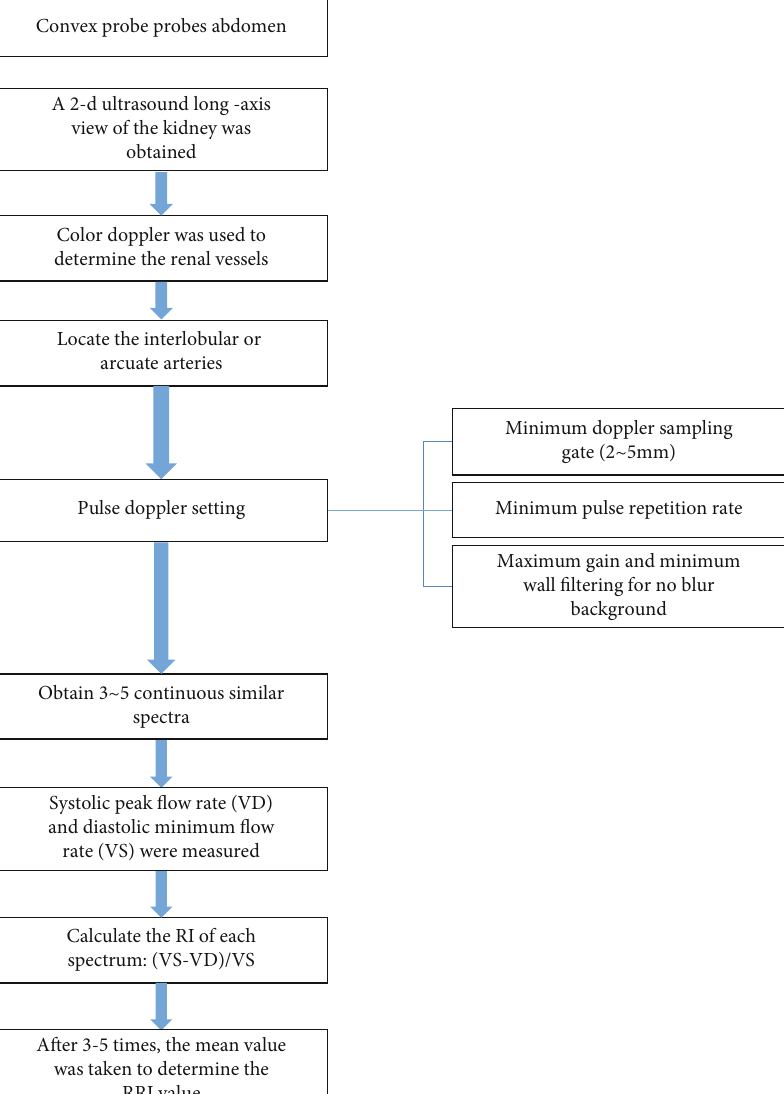
Figure 1: Flow chart of RRI